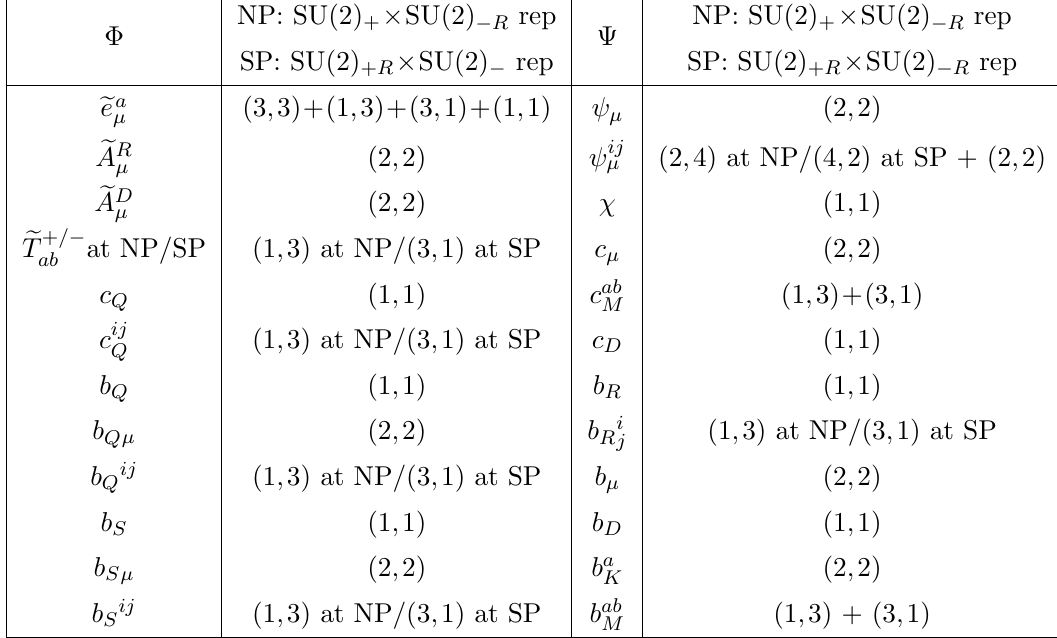
Table 6 . The twisted representation labels of the elementary bosons and fermions of the Weyl